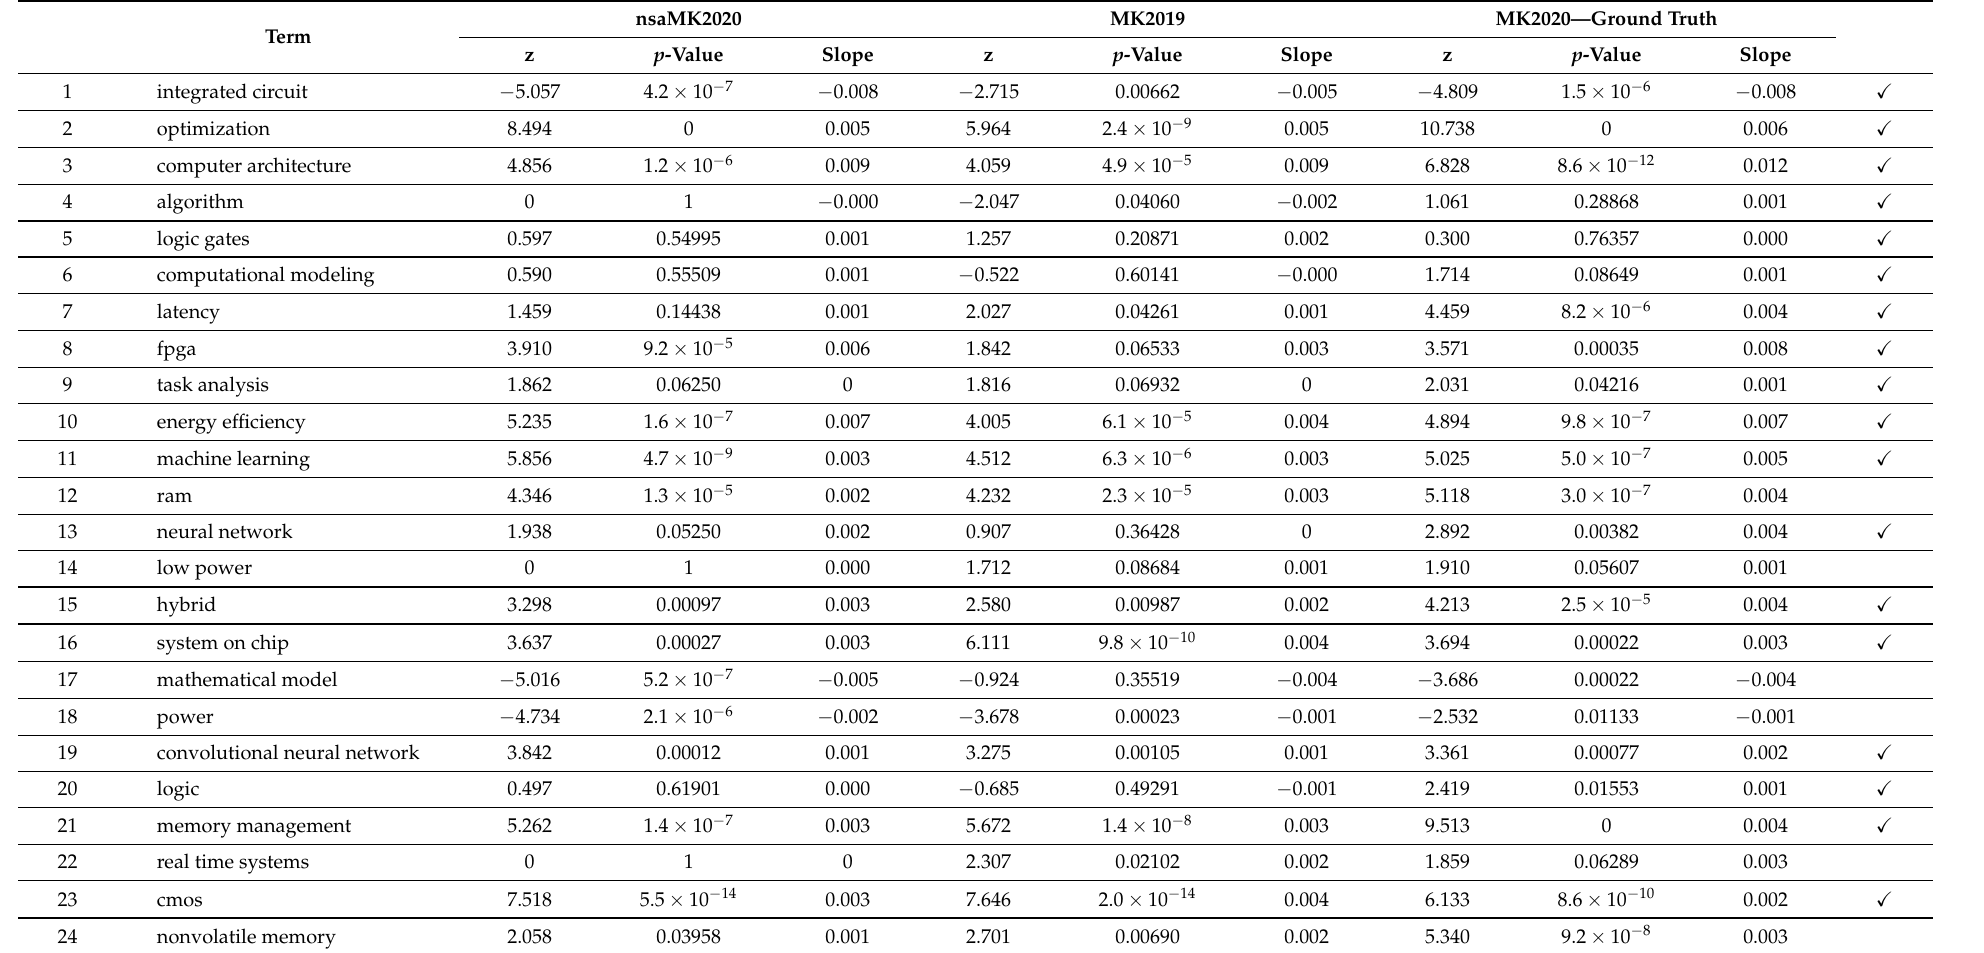
Table 2. Comparison results of nsaMK and MK methods for the top 24 terms in